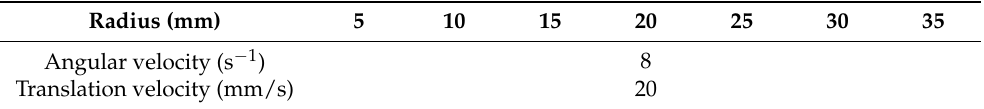
Figure 8. Variation curve of powder layer density under the radius of different recoaters. Table 3. Motion parameters and structural parameters during the movement of the powder recoater with different radiuses.